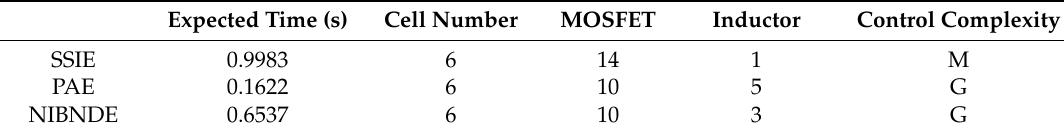
Table 5. The comparison between SSIE, PAE and NIBNDE in a six cell battery string (G: Good; M: Marginal; P: Poor).